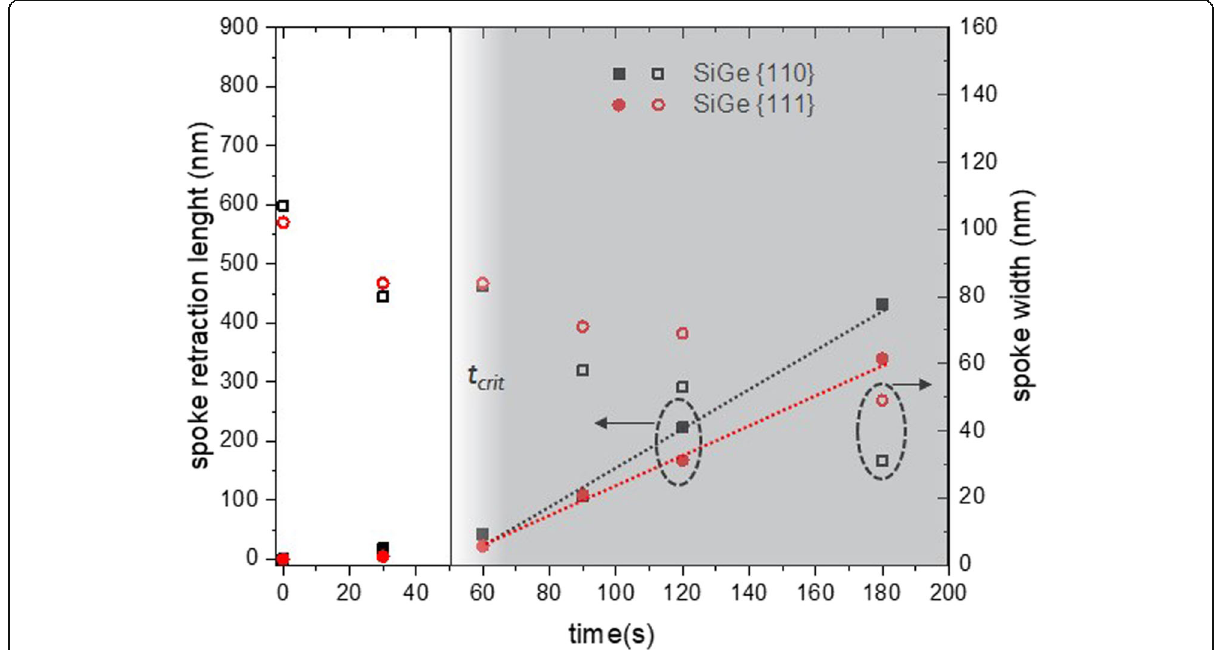
Fig. 7 Etching of Si75Ge25 spokes: the spoke width decreases gradually, but only after a certain tcrit., the spoke tips start to retract and the